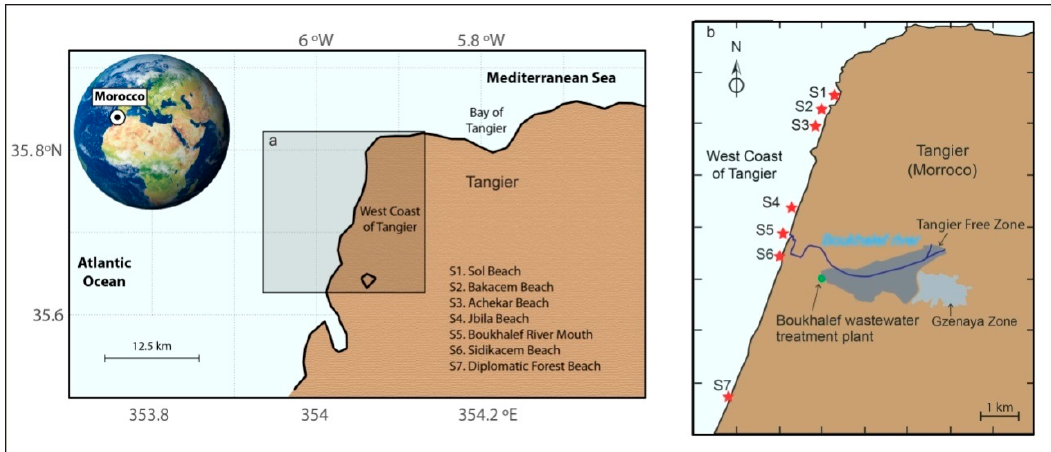
Figure 1. Study area on the west coast of Tangier, northern Morocco ( a ) with the location of seven surveying stations, the Boukhalef river, Boukhalef wastewater treatment station, and the two industrial zones (Tangier Free Zone and Gzenaya Zone) ( b ).